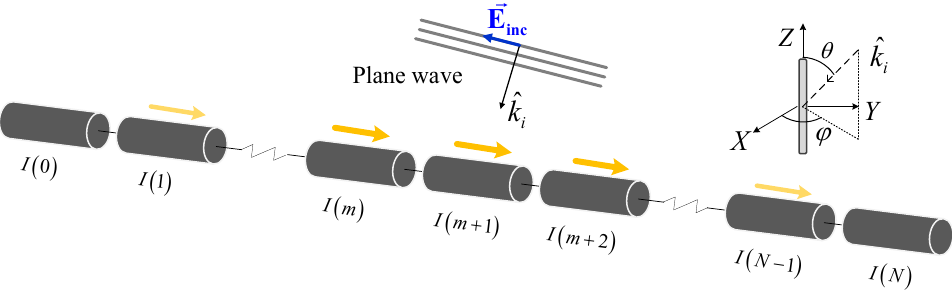
Figure 2. Induced currents on chaff segments under plane wave incidence.